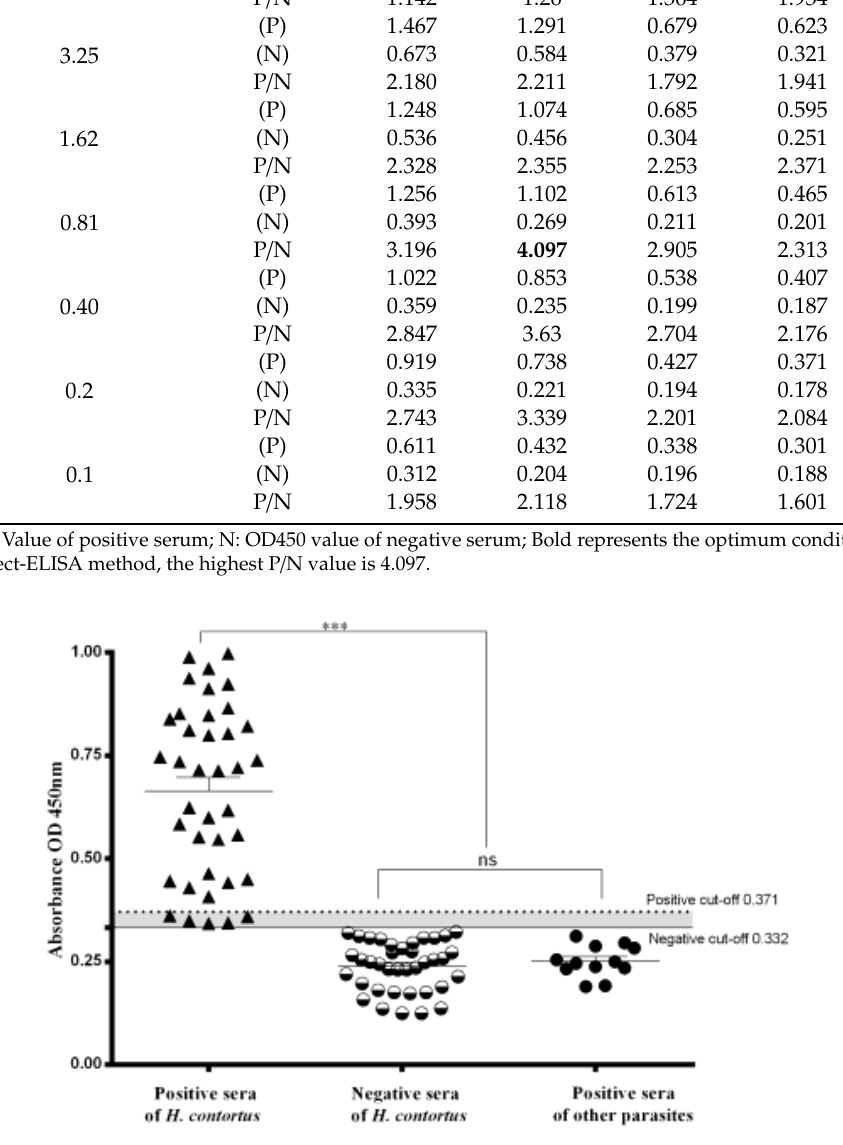
Figure 3. Sensitivity, specificity, and cross-reactivity of indirect-ELISA based on rHc-HCA59. The dotted horizontal line represents the positive cut-off value (OD 450 = 0.371). The solid horizontal line represents the negative cut-off value (OD 450 = 0.332). Statistically significant differences were observed between H. contortus -positive sera and the other organisms’ sera ( T. gondii , F. hepatica , and T. spiralis -positive) and H. contortus -negative sera. No significant difference was noted between the H. contortus -negative and other parasites-positive serum samples.